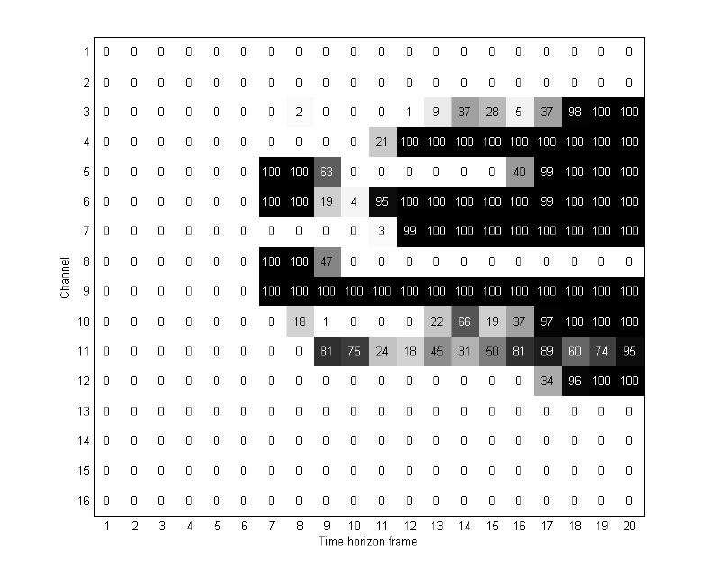
Figure 9. The two-dimensional discriminant information map U M